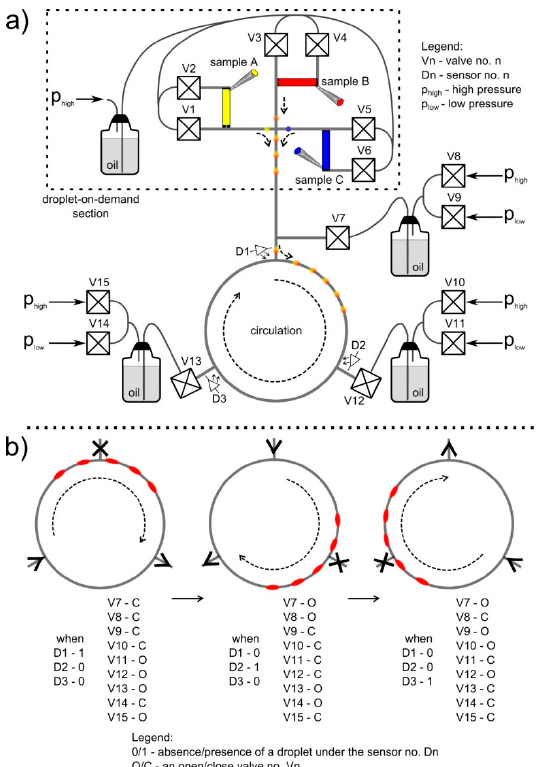
Figure 2. ( a ) Scheme of the microfluidic system. It consisted of the droplet-on-demand section, three parts of the capillary tubing connected to each other (forming loop), and pressurized oil containers with T-junctions. ( b ) The sequential turning of the two-state valves placed on the connectors to pressurized containers provided a constant orientation of the motion of droplets inside the loop. The switching of the valves had been selected in such a way as to ensure the circulation of droplets following the clockwise direction. Arrows on the channels show the direction of oil flow. X indicates no